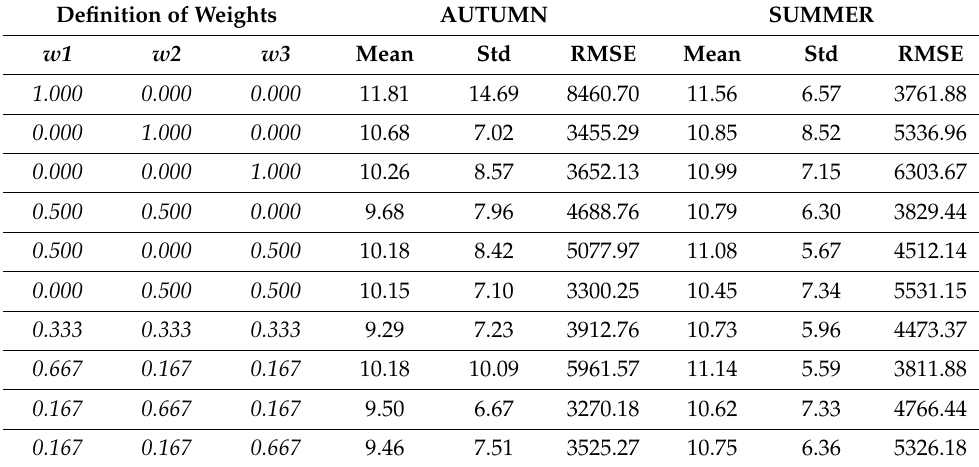
Table 6. Mixture DOE arrangement considering three elements to be combined. Results for autumn and winter are listed.